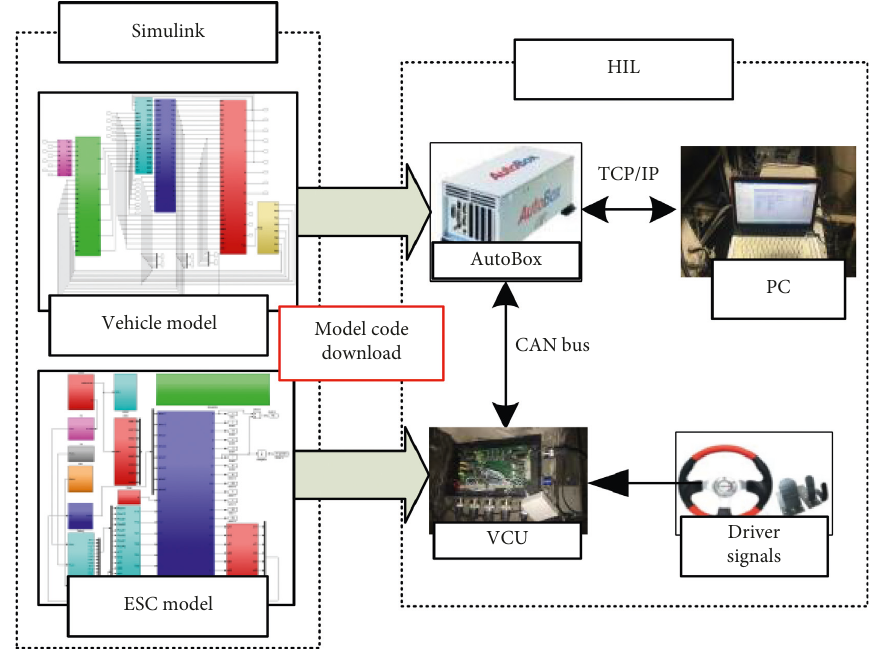
Figure 15: Schematic process of the HIL system.